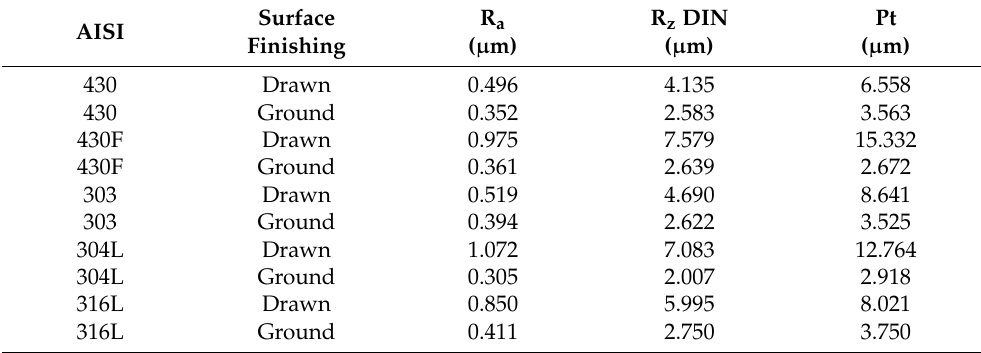
Table 3. Arithmetic mean roughness (R a ), mean roughness depth (R z DIN), and maximum profile depth (P t ) for the different steel grades and surface finishes.